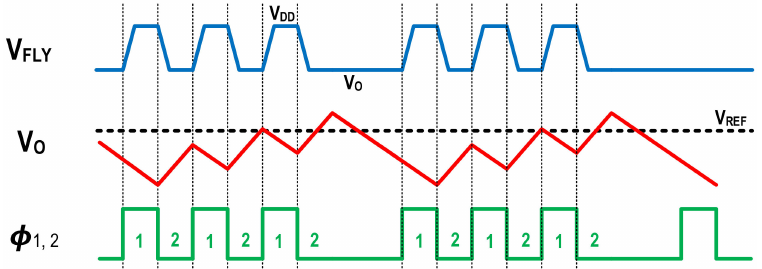
Figure 4. Operation of the proposed SIC converter in the micro switched-capacitor converter ( µ -SCC) mode.